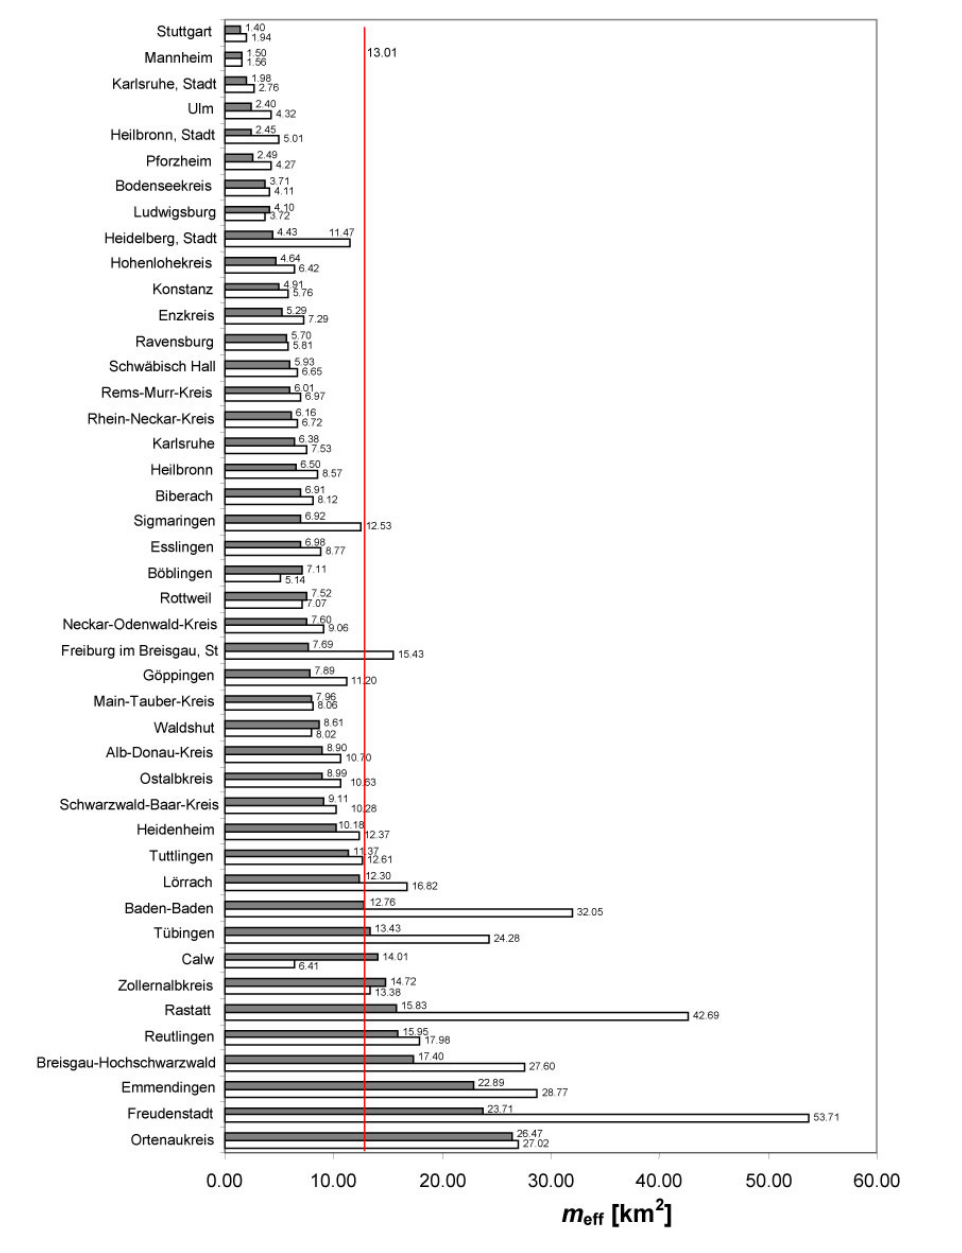
Fig. 5. Data on the current (2004) degree of landscape fragmentation in the 44 rural districts of Baden- Württemberg (including municipal roads). Two methods were compared: the cutting-out (CUT) procedure (dark bars) and the central-point (CTRP) procedure (light bars; see text for explanation of the methods). The order of the rural districts is according to increasing values of the effective mesh size ( m ) as measured by the CUT procedure. For comparisons, the value of the m eff Baden-Württemberg is shown by a solid line (13.01